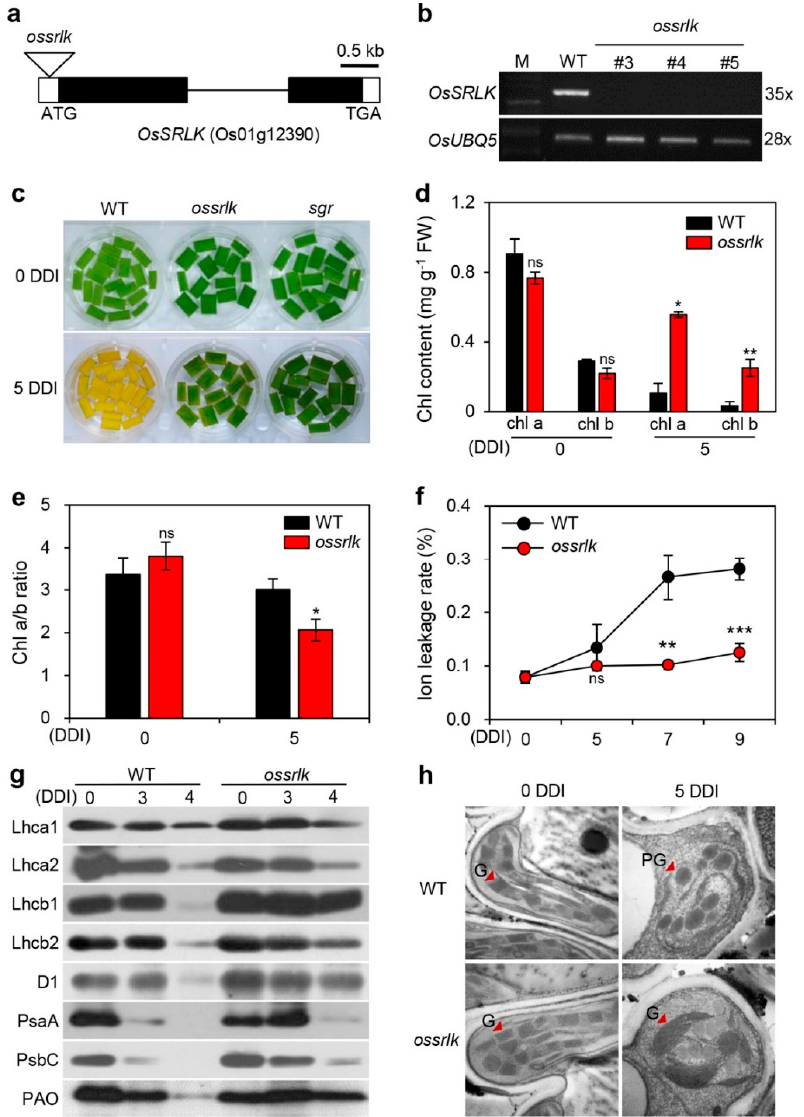
Figure 2. The ossrlk mutant shows a delay in leaf yellowing during dark-induced senescence. ( a ) Schematic diagram depicting the positions of T-DNA insertions in OsSRLK . Black and white bars represent the exon and untranslated region, respectively. The black line represents the intron. The triangle indicates the ossrlk mutant (PFG_1A-15835). ( b ) Mutation of OsSRLK verified by semiquantitative RT-PCR. OsUBQ5 was used as a loading control. The Arabic numerals on the right side of images indicate the numbers of PCR cycles. ( c – f ) Detached leaves of WT, ossrlk , and sgr plants grown in paddy soil for three weeks were incubated in 3 mM 2-( N -morpholino)ethanesulfonic acid (MES) buffer (pH 5.8) under complete darkness at 28 °C. ( c ) The leaf yellowing phenotypes were observed at 0 and 5 DDI. Total chlorophyll contents ( d ), Chl a / b ratios ( e ), and ion leakage rates ( f ) were determined in WT and ossrlk during dark incubation. Mean and standard deviation values were obtained from the three biological repeats. Asterisks indicate a significant difference between WT and ossrlk mutant (Student’s t -test, * p < 0.05, ** p < 0.01, *** p < 0.001). Chl, chlorophyll; FW, fresh weight; ns, not significant. These experiments were repeated thrice with similar results. ( g ) Immunoblotting of detached leaves from WT and ossrlk plants at 0, 3, and 4 DDI using antibodies against photosynthetic proteins (Lhca1, Lhca2, Lhcb1, Lhcb2, D1, PsaA, PsbC, and PAO). ( h ) Transmission electron microscopy images were obtained from detached leaves of three-week-old WT and osdof24-D at 0 and 5 DDI, as depicted in Figure 2c. These experiments were repeated twice with similar results. G, grana (stack of thylakoids); PG, plastoglobule. Scale bars = 5 μ m.